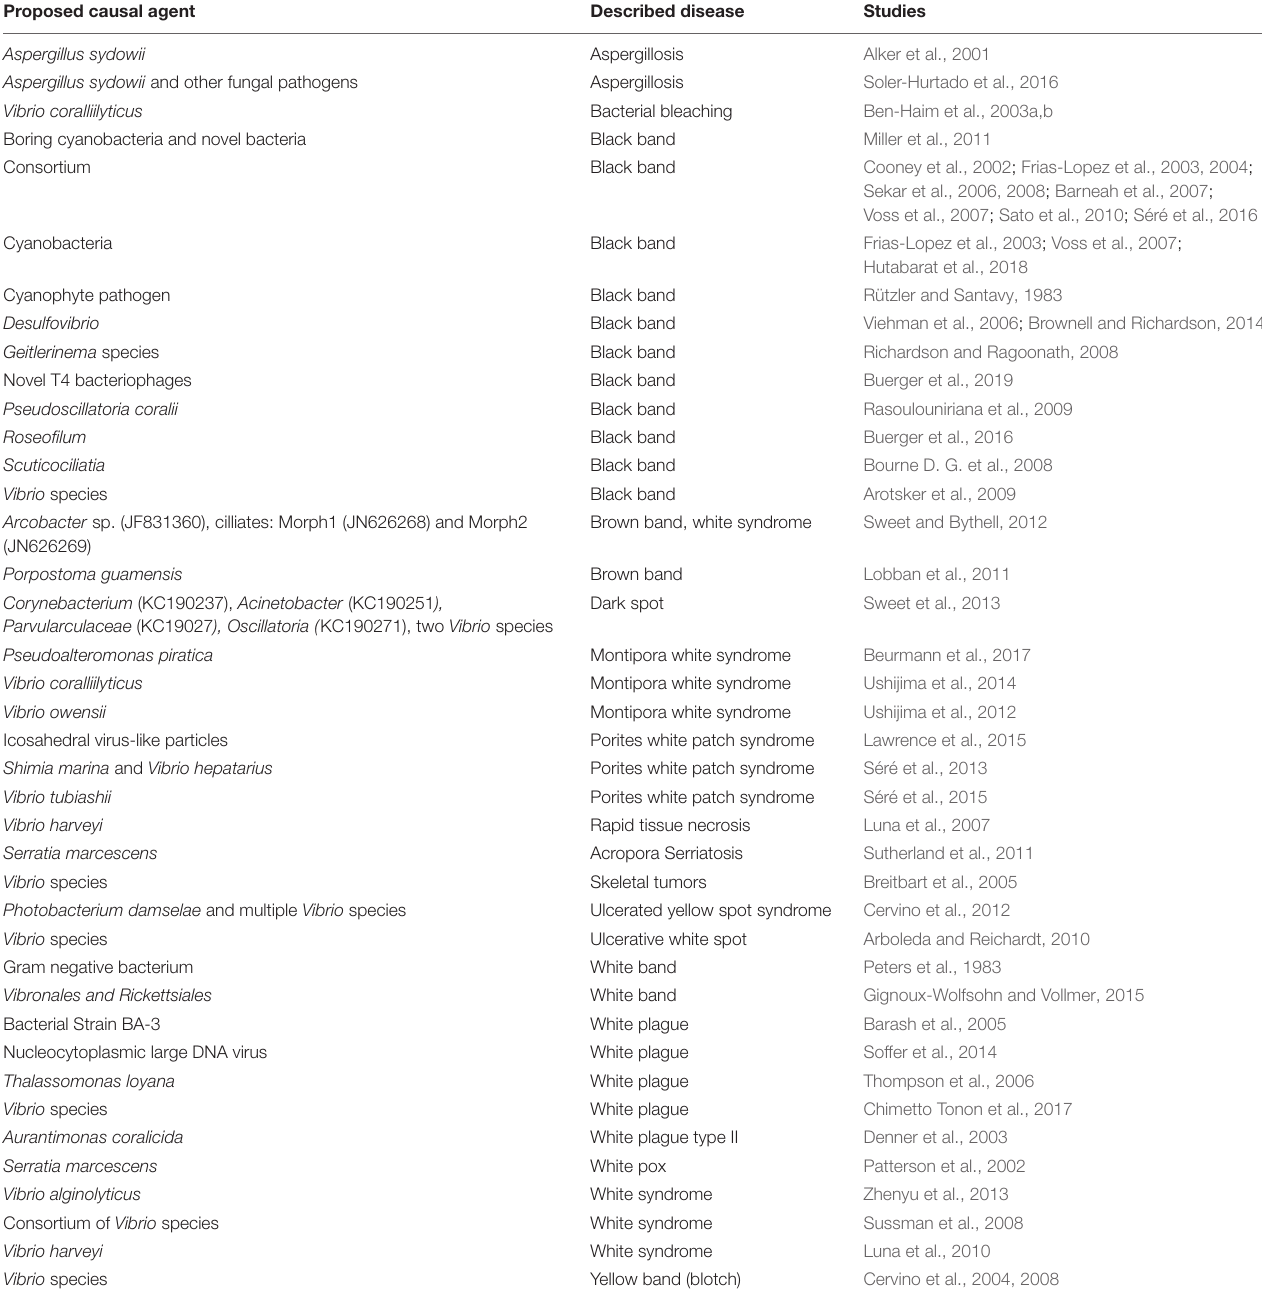
TABLE 2 | Proposed causative agents to coral